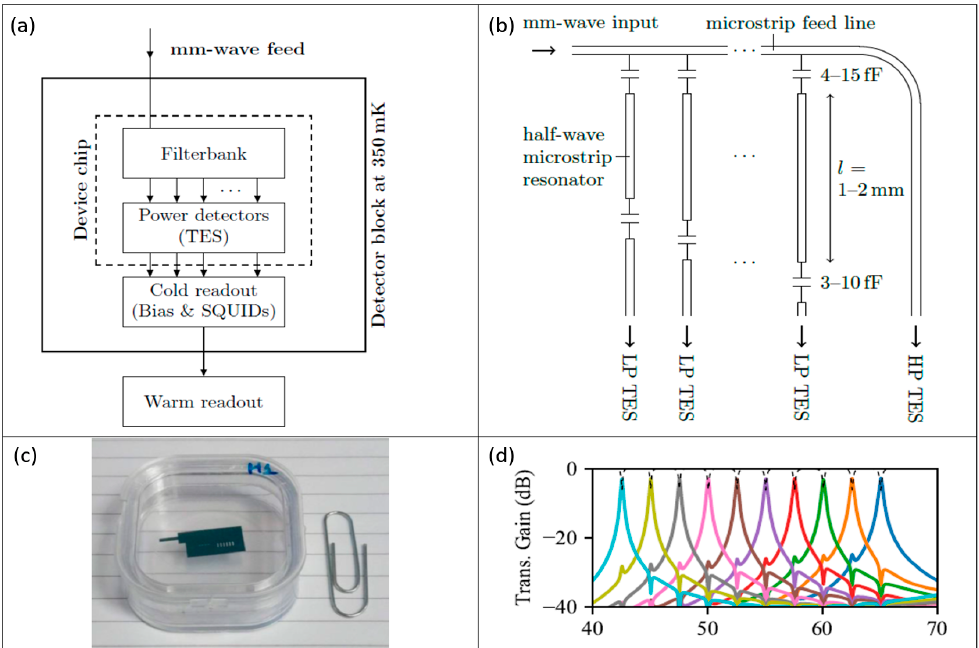
Figure 1. Schematic of a superconducting filterbank based on transition-edge superconducting detector technology. ( a ) Overall filterbank architecture. ( b ) Schematic of filterbank – half-wave resonator coupled to feedline and TES detector. ( c ) Prototype 10-channel low spectral resolurion ( R =200) device chip. ( d ) Modelled filter response ( R =200). Figures from Thomas et al. [16].